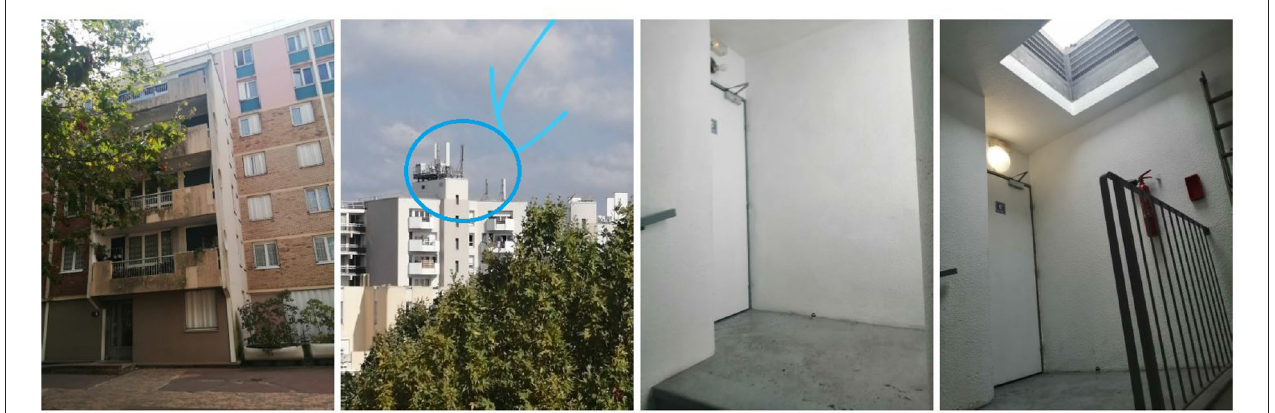
FIGURE 1 | Measurement environment. From left to right : Front look, Base station, Floor 5, Floor 6.